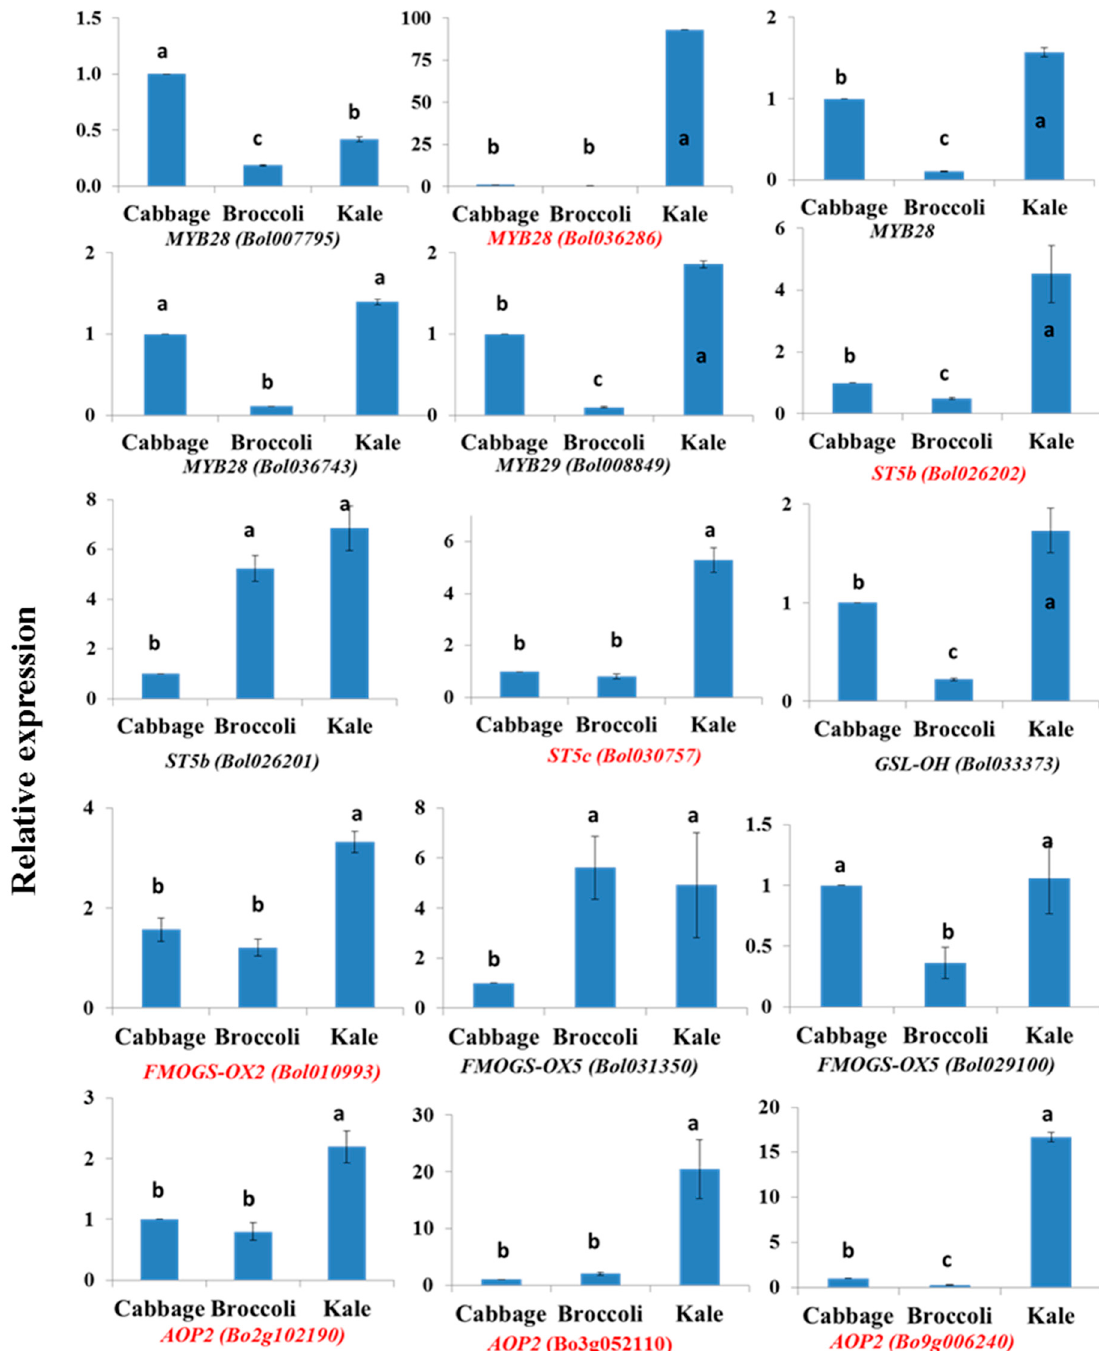
Figure 3. Subspecies variation in aliphatic glucosinolate biosynthesis-related gene expression in the control cabbage, broccoli and kale leaves. Vertical bars indicate standard deviation of means. Different letters indicate statistically significant differences between subspecies at 1% level of significance in one-way ANOVA. Genes with red letters were highly expressed only in kale.